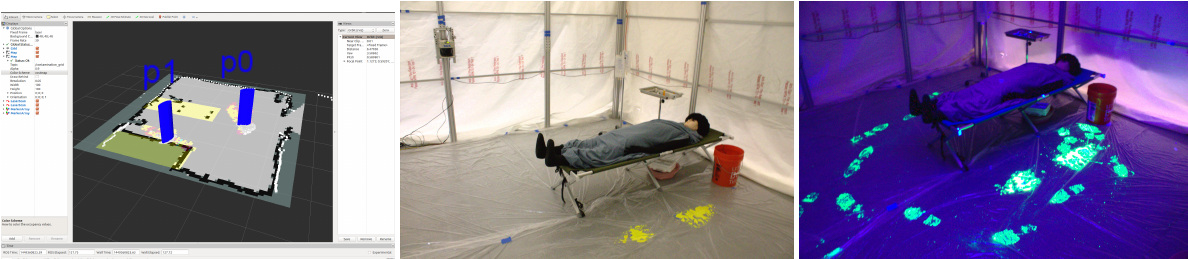
Figure 1. ( Left ): Tracking visualization. ( Middle ): Initial condition, showing paint. ( Right ): Final condition, showing paint under ultraviolet illumination.